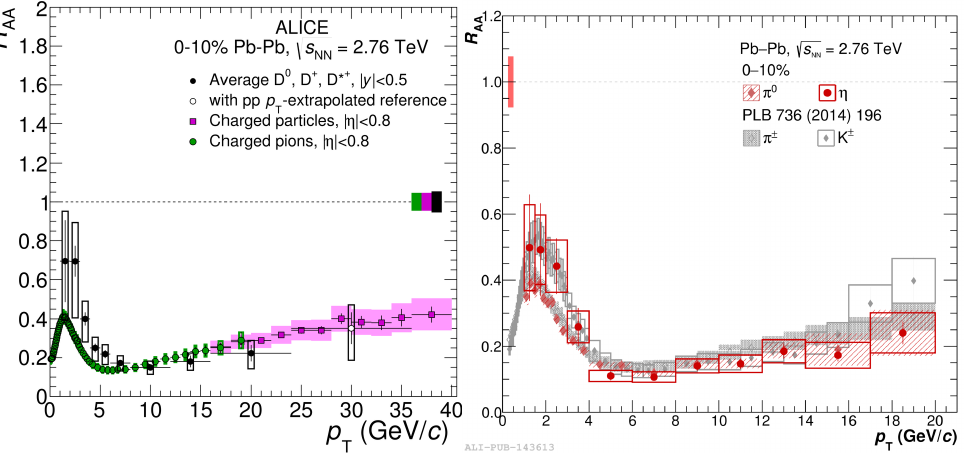
Figure 14. Left : Prompt D-meson R AA as a function of p T compared to the nuclear modification factors of charged pions and charged particles in the 0–10% centrality class [37]. Right : R AA of neutral and charged pions, kaons and eta meson